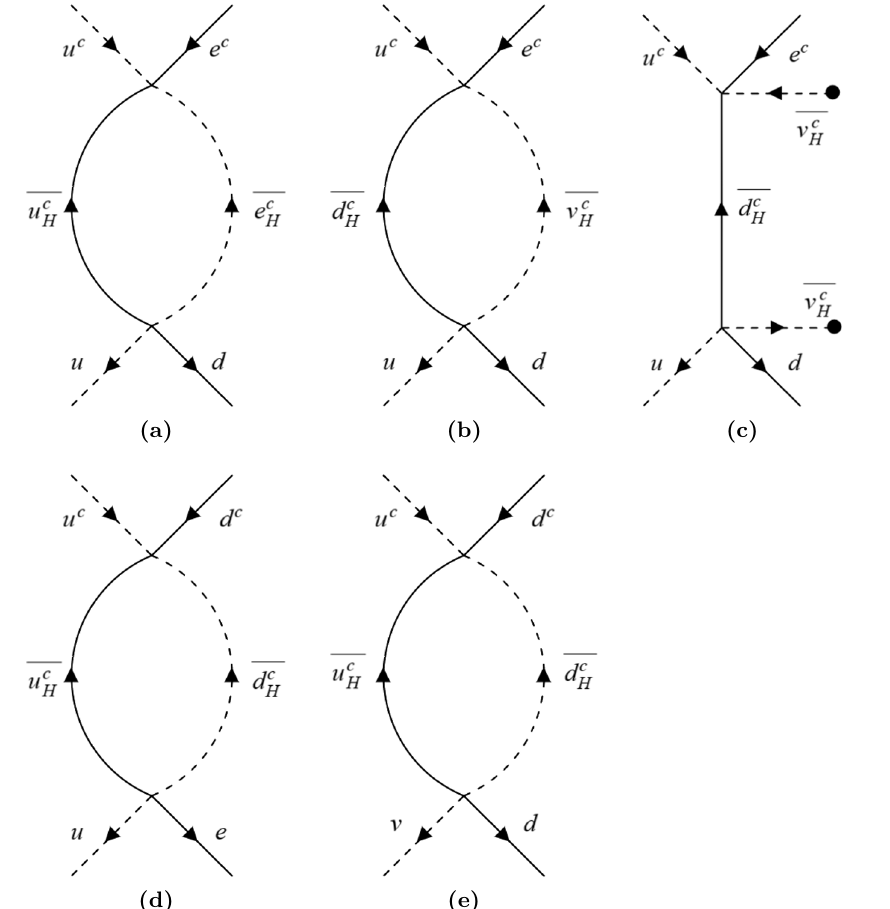
Figure 3. Dimension-(cid:12)ve proton decay diagrams. Dashed lines represent bosons, solid lines repre- sent fermions, and dots represent the vevs. These are graphs between the B -violating superpotential coupling FFH c H c and the B -conserving superpotential coupling F c F c H c H c